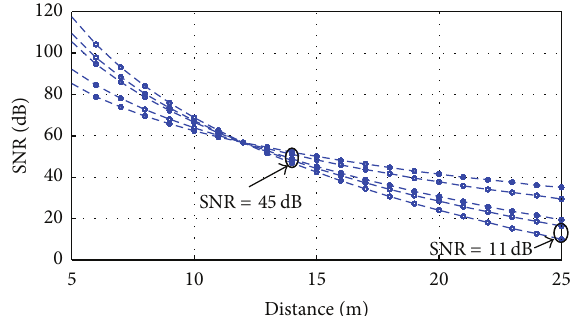
Figure 9: The interaction of SNR with the channel to determine the transitional region.